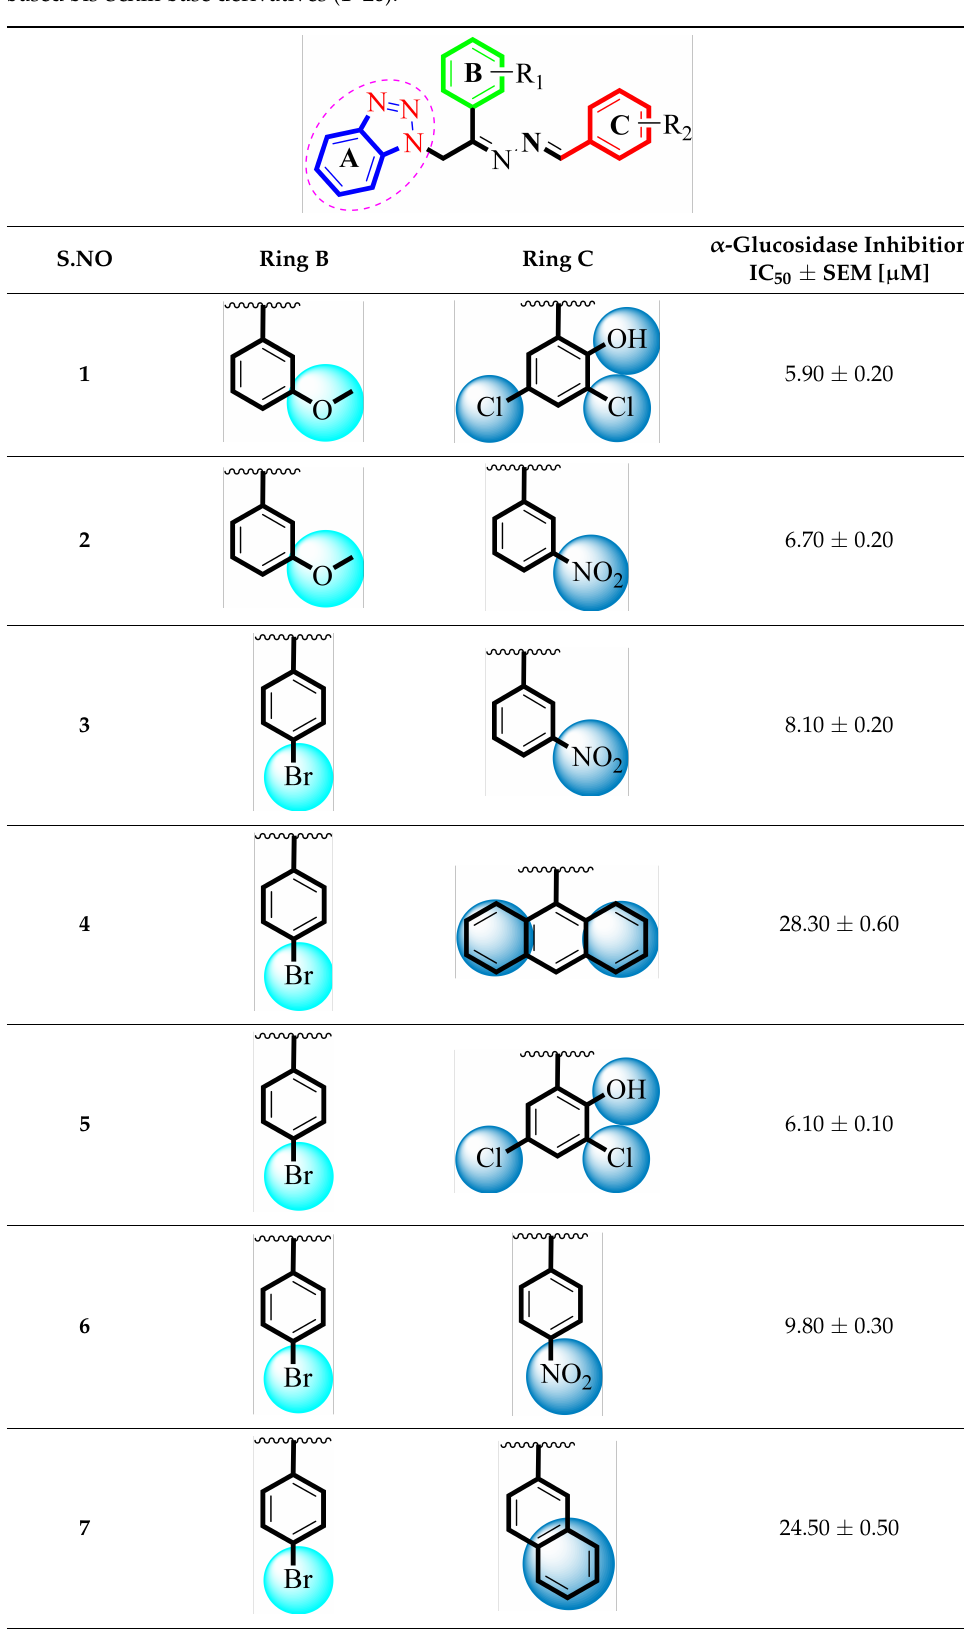
Table 1. Different substituents and in vitro the α -glucosidase inhibitory potentials of benzotriazole- based bis-Schiff base derivatives ( 1 – 20